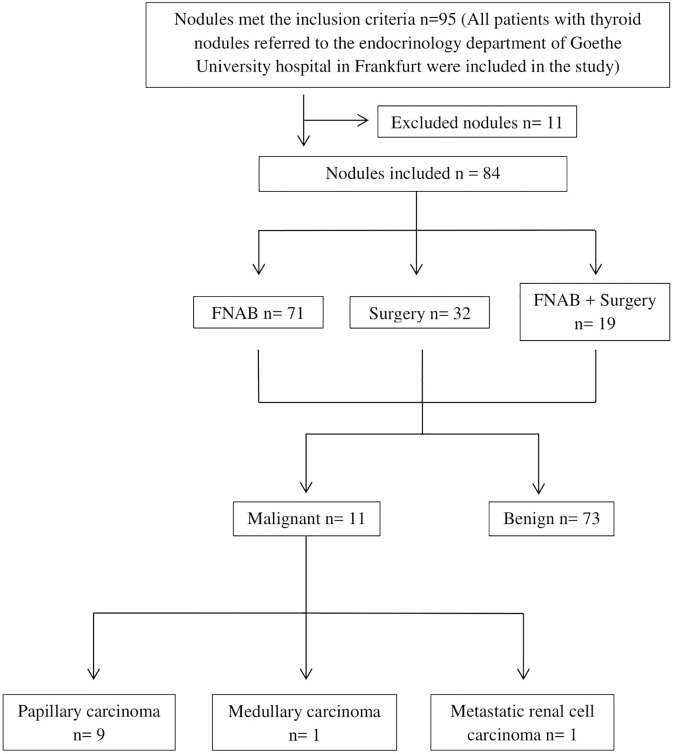
Number of nodules that underwent FNAB and/or surgery, number of benign and malignant thyroid nodules and types of thyroid cancer.